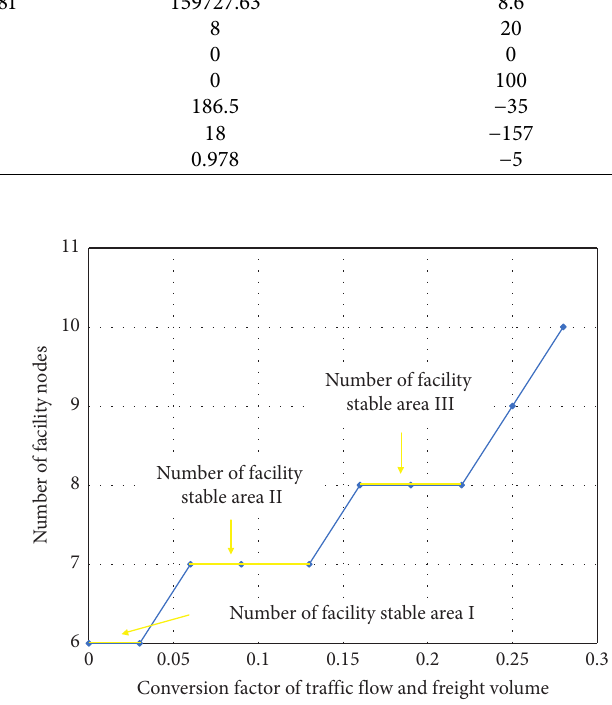
Figure 8: Variation of facility location nodes by parameter δ